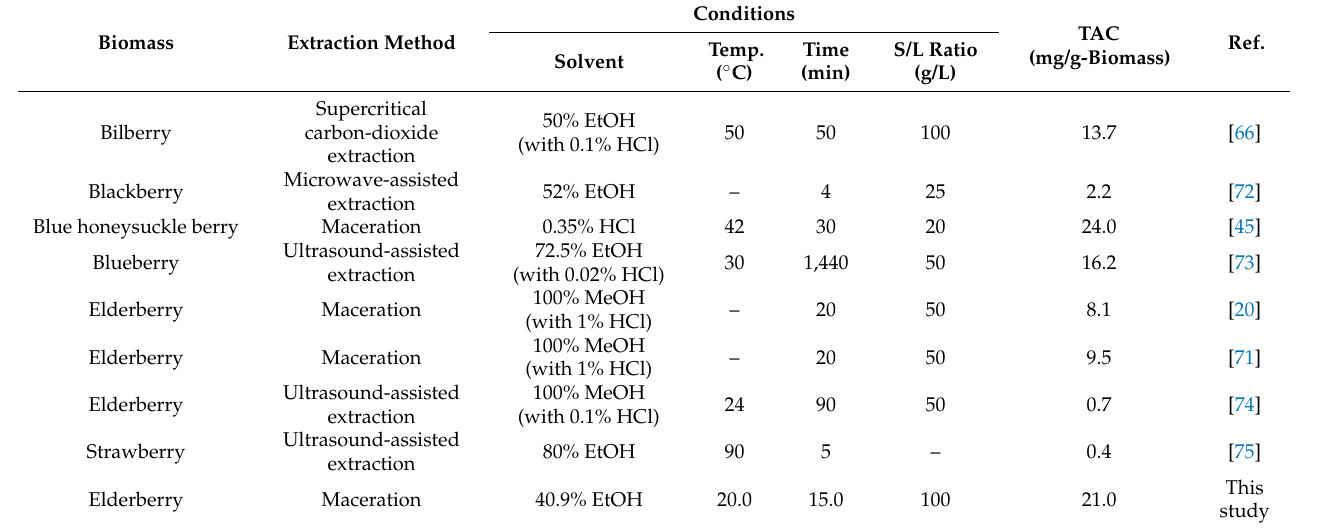
Table 7. Summary of various literature on anthocyanin recovery from